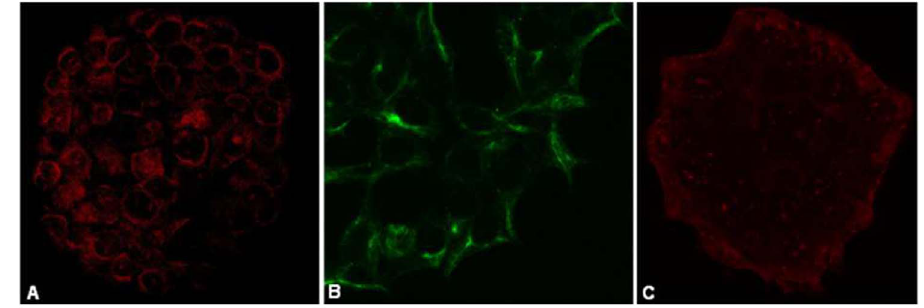
Figure 1. Phenotyping cultured human cardiomyocytes. Human cardiomyocytes cultured on microscope cover slips where phenotyped using cardiac markers (A) a -MHC (63 6 magnification) (AF546-labeled secondary antibody [red]) (B) Cx43 (x40) (AF488-labeled primary antibody [green]) and (C) cTnT (40 6 magnification) (AF546-labeled secondary antibody [red]). Cardiomyocytes where imaged on a Zeiss 780 immunofluorescent confocal microscope.